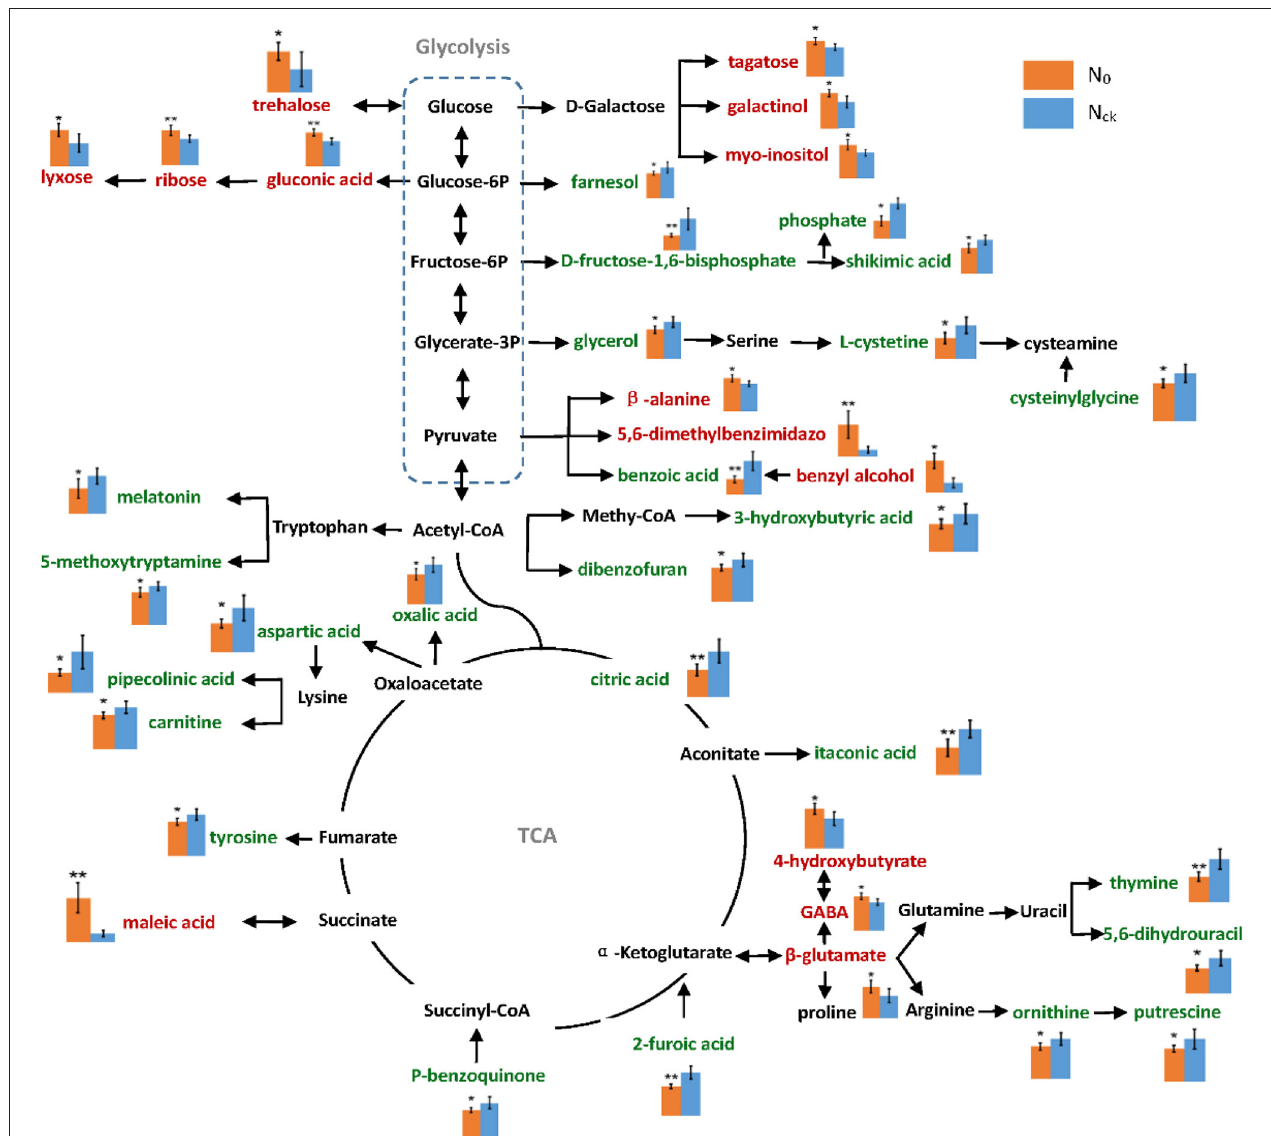
FIGURE 8 | Metabolic pathway network of differentially accumulated metabolites under N0 and Nck conditions. The relative content levels of metabolites are shown in column charts: orange color column represents N0, and blue color represents Nck. The words in green color represent down-regulated metabolites, and those in red color represent up-regulated metabolites. The errors are shown in all bar graphs, and a significant difference between N0 and Nck in each metabolite is also evaluated, * P < 0.05 significant difference, ** P < 0.01 extremely significant difference.